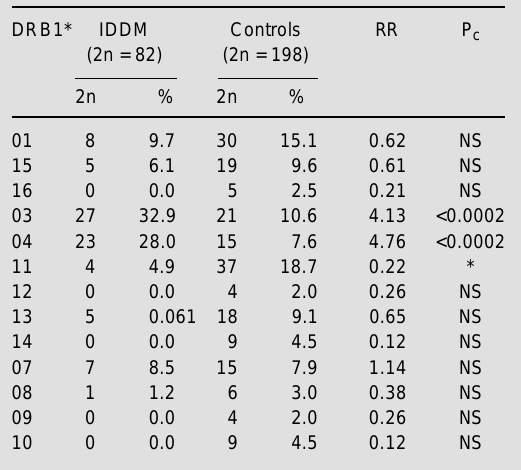
Table 2 - Distribution of HLA-DRB1 allele frequencies in IDDM patients and normal individuals (controls). The frequencies are represented as a percentage of each allele in relation to the total number of alleles (2n) (when a single DRB1 allele was found it was considered homozy- gous and was counted twice). P values were obtained by the chi-square test and corrected for the number of differ- ent DRB1 alleles tested (P c , multiplication of P by 13). RR, Relative risk; NS, nonsignificant. *P<0.006 before correc- tion.